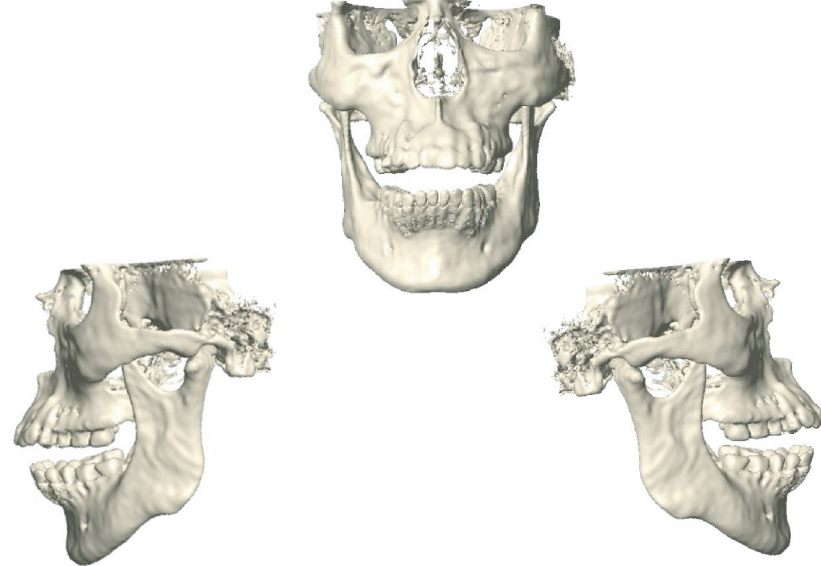
Figure 7: High-bio fi delity biomodel of the patient, generated from the latest generation tomography, necessary to perform the numerical